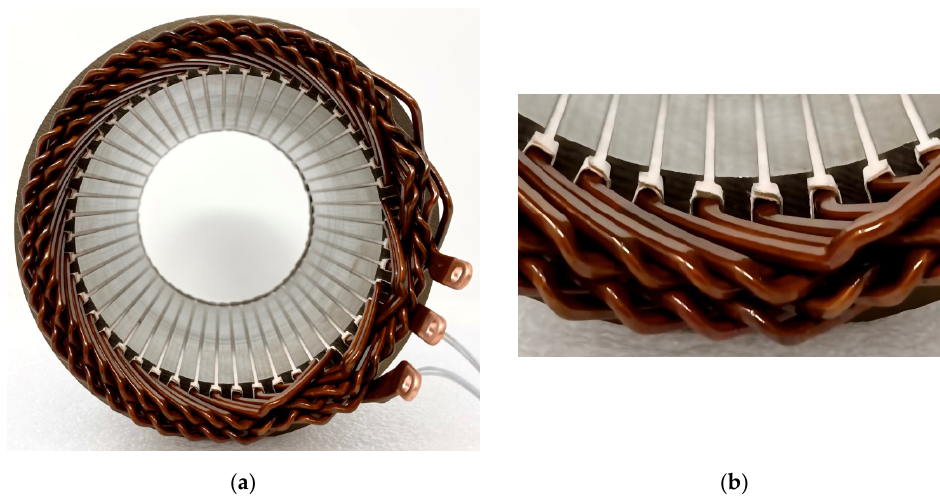
Figure 3. 3D ‐ printed hairpin stator winding, reproduced with permission from the owner, Addi ‐ tive|Drives GmbH (Germany) [102]. ( a ) Wound stator; ( b ) end ‐ windings. tive|Drives GmbH (Germany) [102]. ( a ) Wound stator; ( b ) end-windings.